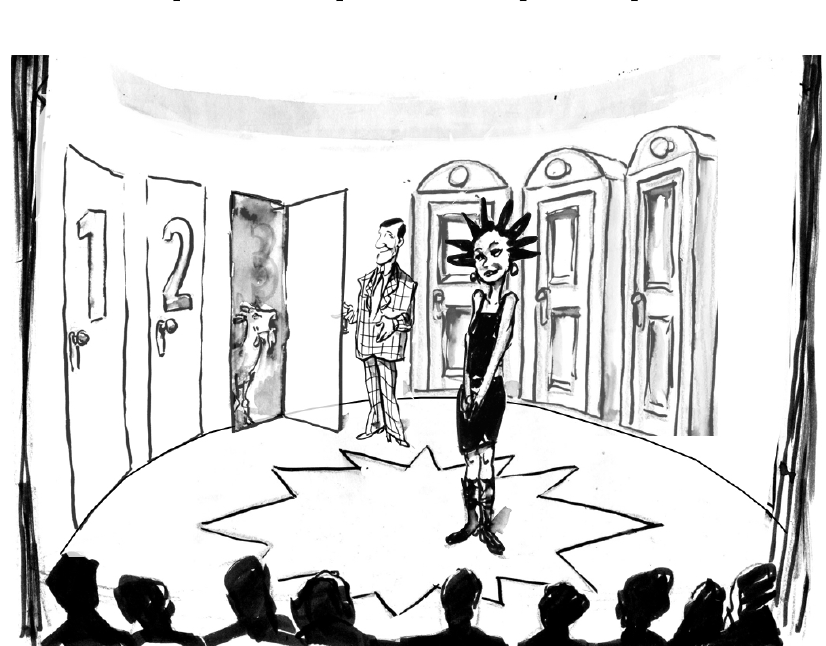
Figure 3. Monty Hall opens one of the doors with a goat behind it for one of the contestants in an episode of “Let’s Make a Deal” with a twist inspired by the Sleeping Beauty Problem (Drawing by Laurent